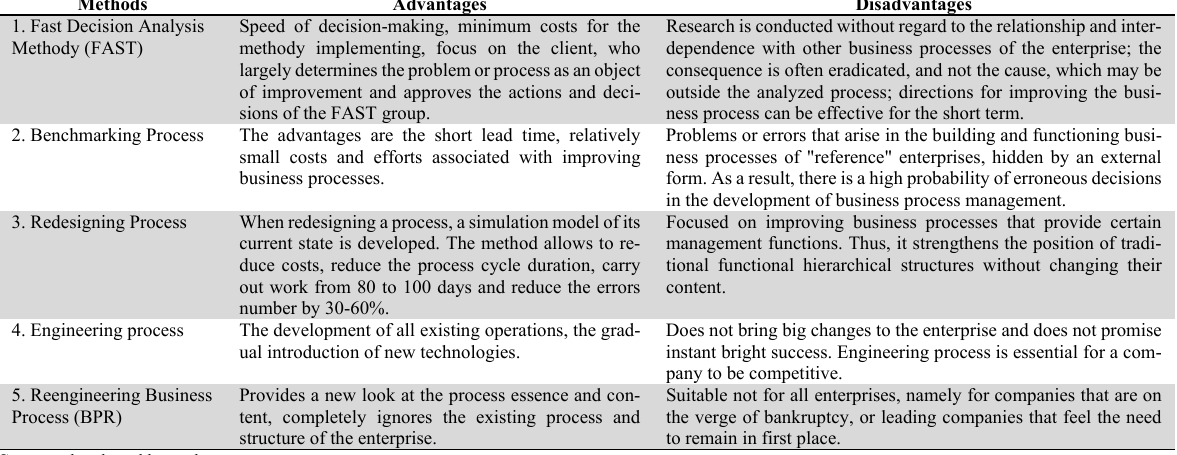
Basic methods for achieving the aims of improving business processes in the food